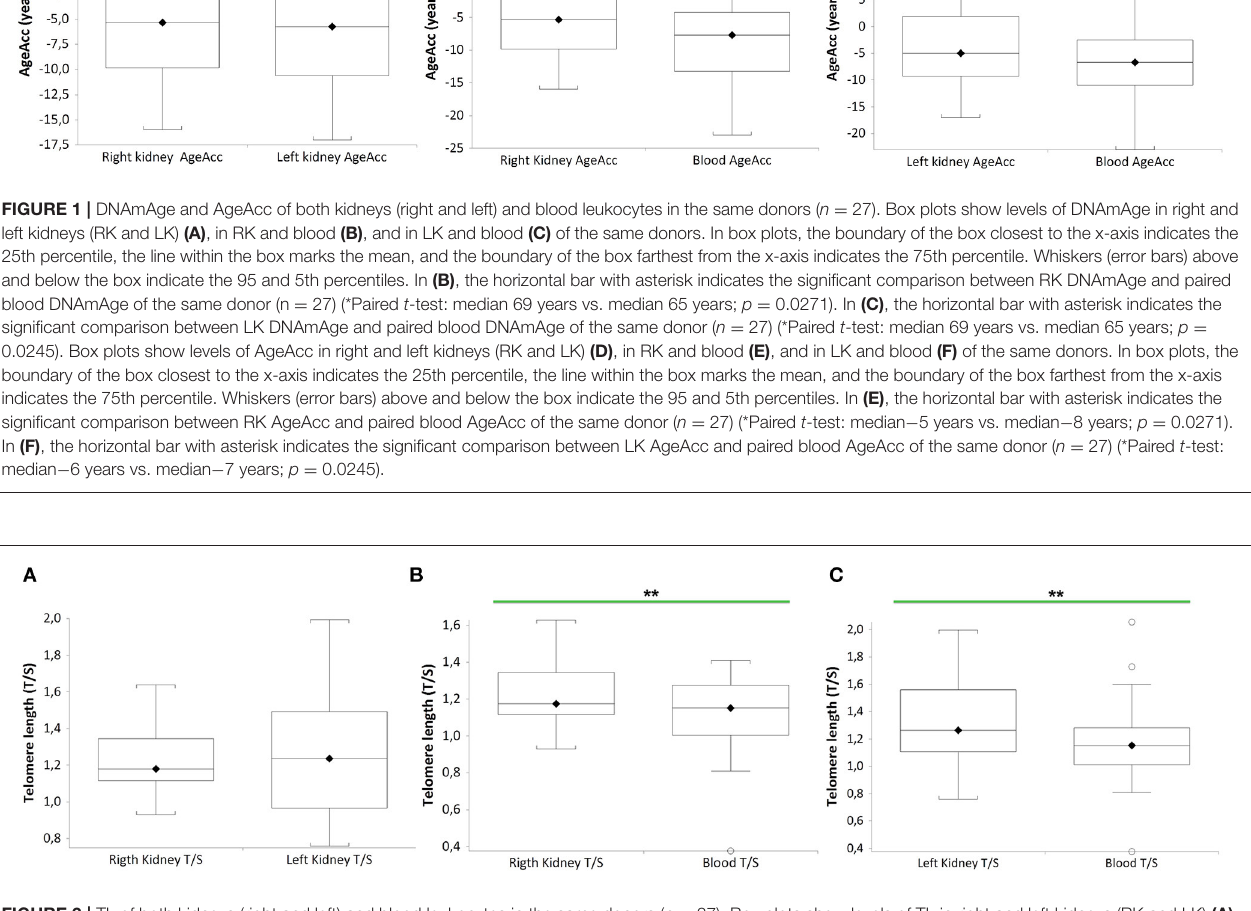
FIGURE 2 | TL of both kidneys (right and left) and blood leukocytes in the same donors ( n = 27). Box plots show levels of TL in right and left kidneys (RK and LK) (A) , in RK and blood (B) , and in LK and blood (C) of the same donors. In box plots, the boundary of the box closest to the x-axis indicates the 25th percentile, the line within the box marks the mean, and the boundary of the box farthest from the x-axis indicates the 75th percentile. Whiskers (error bars) above and below the box indicate the 95 and 5th percentiles. In (B) , the horizontal bar with asterisks indicates the significant comparison between RK TL and paired blood TL of the same donor ( n = 27) (**Paired t -test: median 1.18 T/S vs. median 1.15 T/S; p = 0.0011). In (C) , the horizontal bar with asterisks indicates the significant comparison between LK TL and paired blood TL of the same donor ( n = 27) (**Paired t -test: median 1.25 T/S vs. median 1.15 T/S; p =